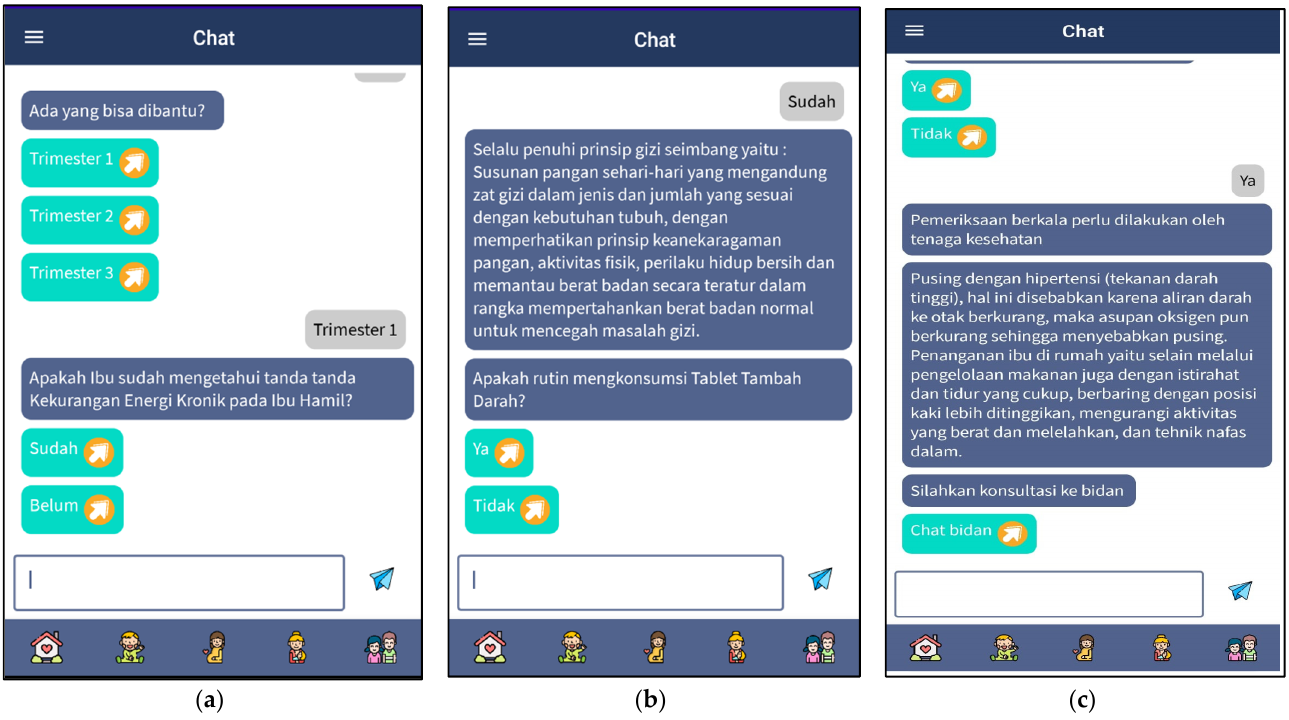
Figure 9. The screen captures the semi-automated chatbot. ( a ) General health screening on a chatbot, ( b ) education on common complaints, and ( c ) chat options for midwives as further complaints.